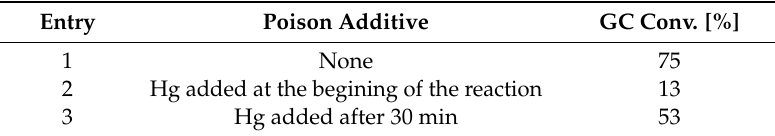
Table 3. Suzuki–Miyaura reaction of 2-bromotoluene with phenylboronic acid catalyzed by Pd/DNA (C2) in the presence of Hg(0) a .